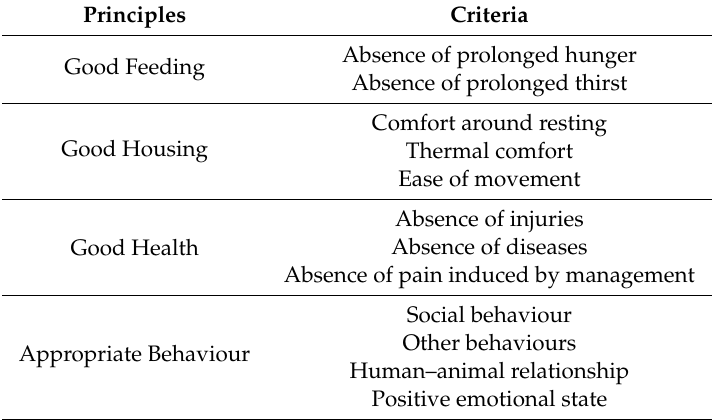
Table 1. Principles and criteria defined in the European Welfare Quality project to assess animal welfare